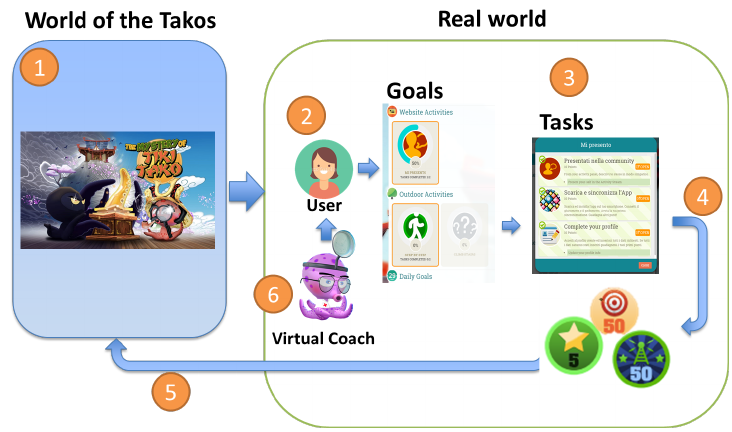
Figure 6. Main characteristics of the Tako Game (see Table 1 for explanation).